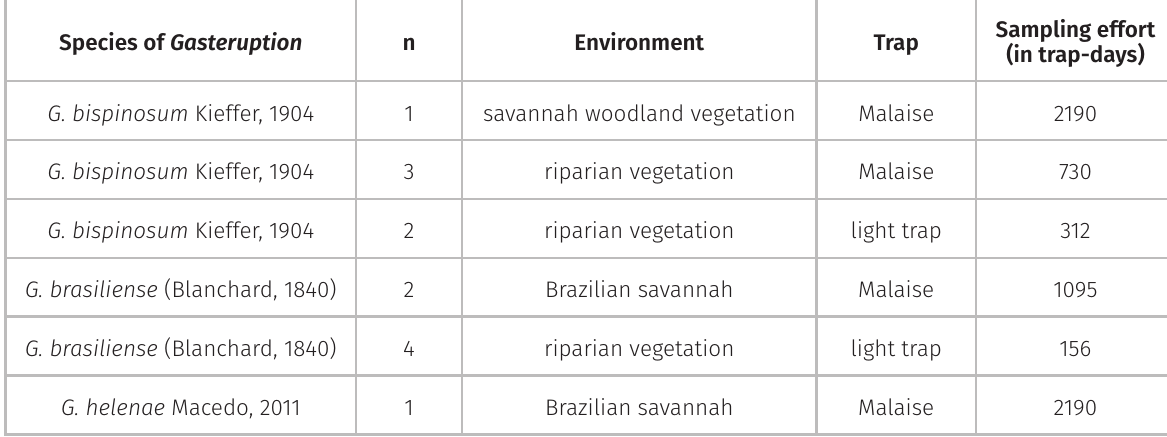
Table I. Species of Gasteruption Latreille, 1796 obtained at the Estação Ecológica de Jataí between January 2007 and December 2009: number of specimens per environment, trap used, and sample effort in trap-days.